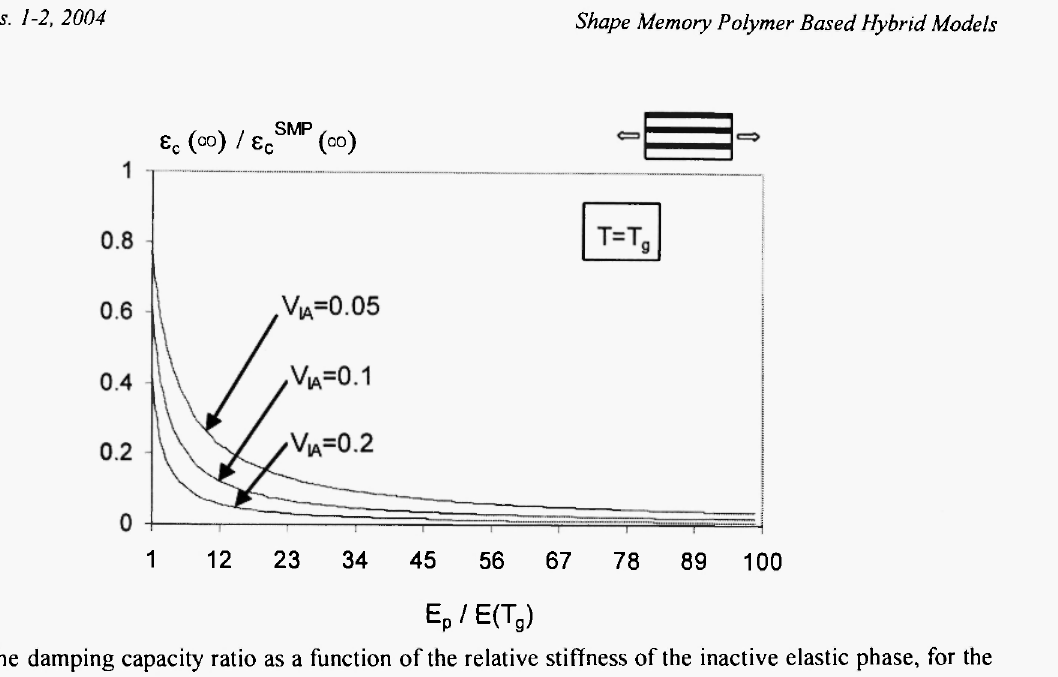
Fig. 7: The damping capacity ratio as a function of the relative stiffness of the inactive elastic phase, for the aligned fiber composite.